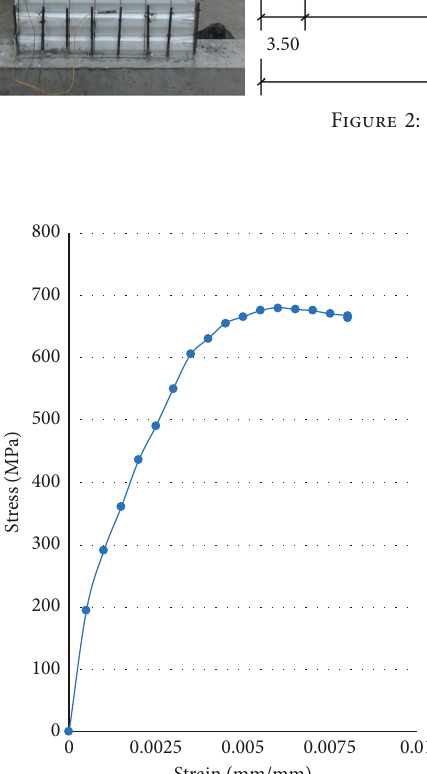
Figure 3: Stress-strain relationship of steel